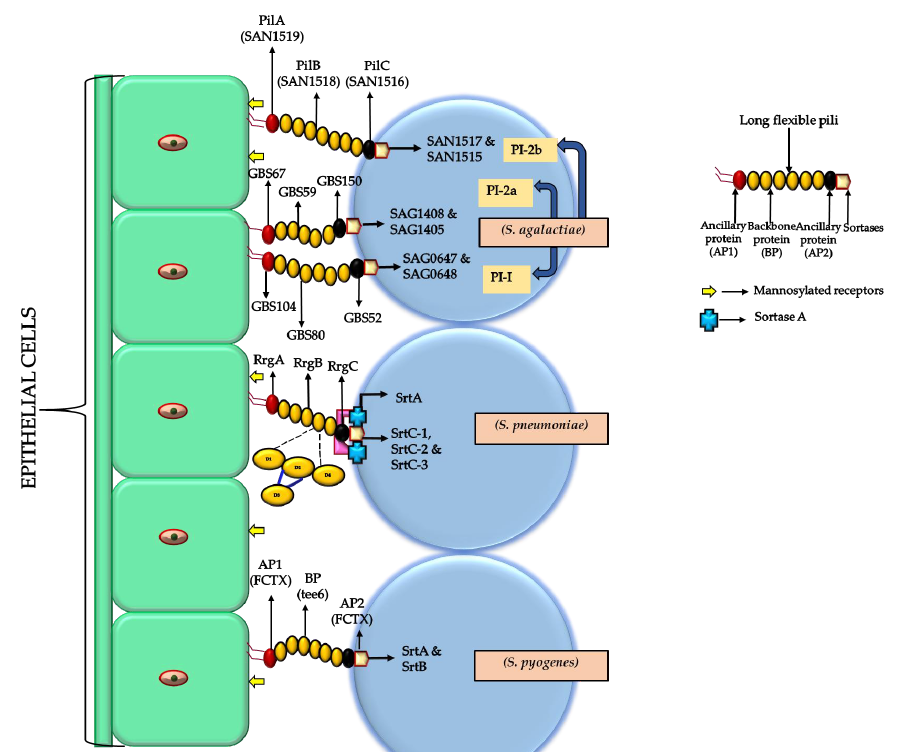
Figure 2. Schematic diagram of general pilus architecture in different streptococci. The blue spheres represent the different bacterial strains, and the green color boxes represent host epithelial cells. The long pili shown in the diagram are formed by three major subunits ancillary protein AP1 (tip protein at the distal end) that attaches to the bacterial surface, backbone protein BP, and ancillary protein AP2, which are assembled by sortases that facilitate adherence with host epithelial cells. AP2 anchors the pilus to the bacterial surface. In S. agalactiae , there are three pilus islands designated as PI-1, PI-2a, and PI-2b. Each pilus island has major protein referred as PI-1 (include GBS104 as AP1, GBS80 as BP, and GBS52 as AP2 with two sortases SAG0647 and SAG0648), in PI-2a (GBS67 as AP1, GBS59 as BP, and GBS150 as AP2 with two sortases SAG1408 and SAG1405), and PI-2b (SAN1519 as AP1, SAN1518 as BP, and SAN1516 as AP2 with two sortases SAN1517 and SAN1515). In S. pneumoniae , pilus subunits are AP1 (RrgA), BP (RrgB), and AP2 (RrgC) with sortases designated as SrtC-1, SrtC-2, and SrtC-3. Here, RrgC does not depend on pilus-specific sortases for adherence to the cell wall; instead, it binds the preformed pilus to the peptidoglycan by retaining the catalytic activity of SrtA (blue box). RrgB is composed of 4 domains D1 at N-terminus, D2 and D3-positioned laterally, D3 connected to D2 through a loop (dark blue color), and D4 at the C-terminus. In S. pyogenes , the three subunits of pilus include pilus BP (tee6), AP1 and AP2 (fctX), and sortases (srtB and srtA) . The monosyl receptors are present on the surface of epithelial cells and respond to the infection (arrow in yellow color). Table 1. Representation of S. pyogenes pilus structure encoding in the Fibronectin-Binding, Collagen- Binding, T-Antigen ( FCT) genomic region, and its effect on biofilm-forming capacity. FCT (Fibronectin-Binding, Collagen- Biofilm Phenotype Binding, T-Antigen) Type Encoding pili FCT type 1 Strong biofilm, independent of media or pH